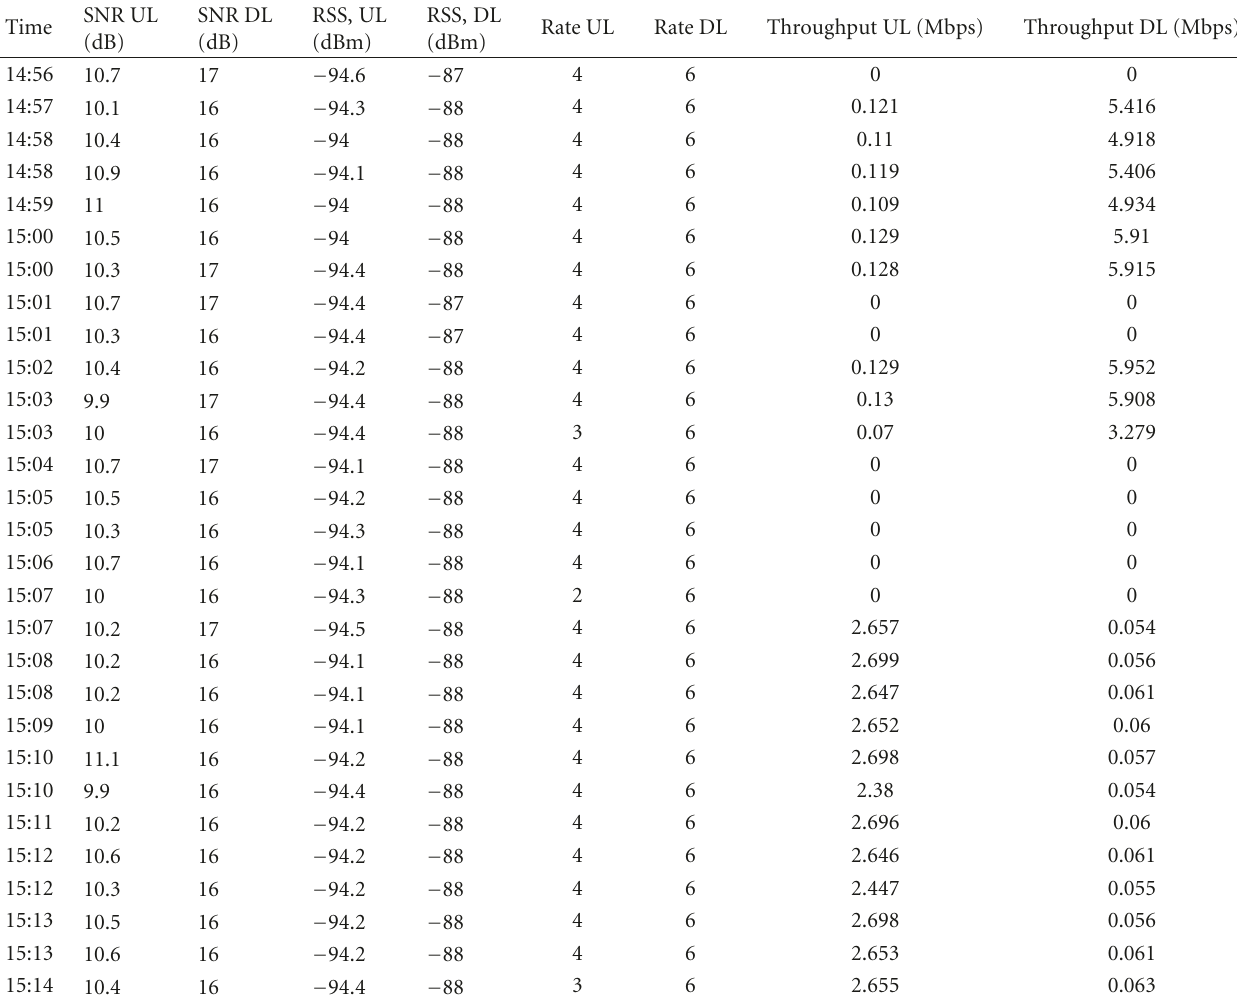
Table 3: Extract from logged WiMAX link